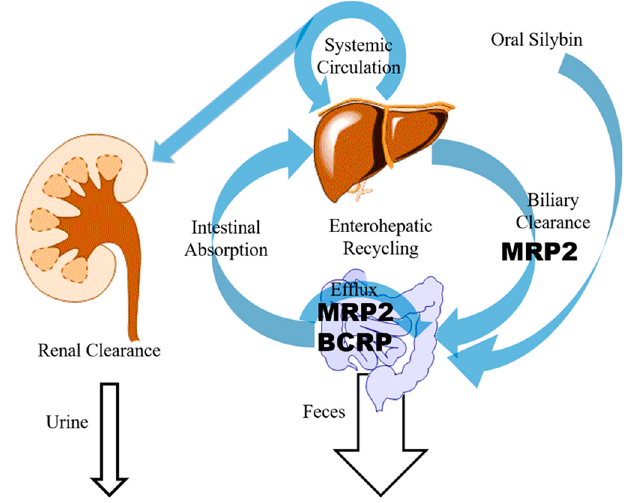
Figure 2. Transporters related to the disposition and elimination of silybin. BCRP: breast cancer resistance protein; MRP2: multidrug resistance-associated protein.